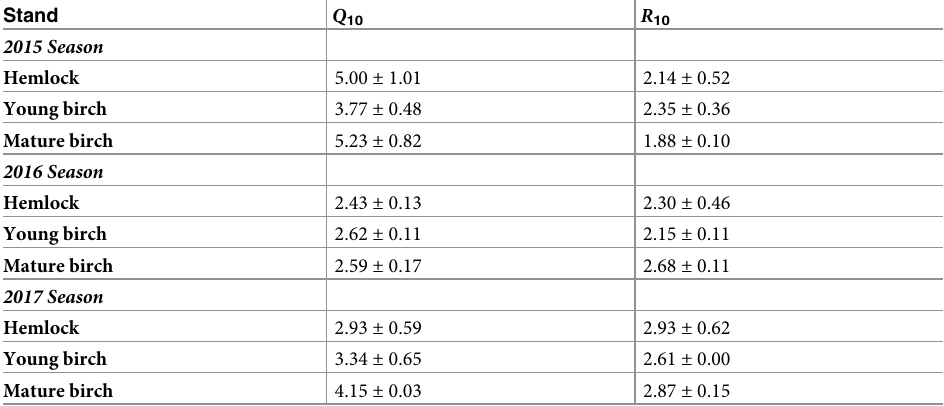
Table 1. Values of Q 10 and R 10 . Mean Q 10 and R 10 (mean ± SE) for each forest type in the 2015, 2016, and 2017 grow- ing season (n =